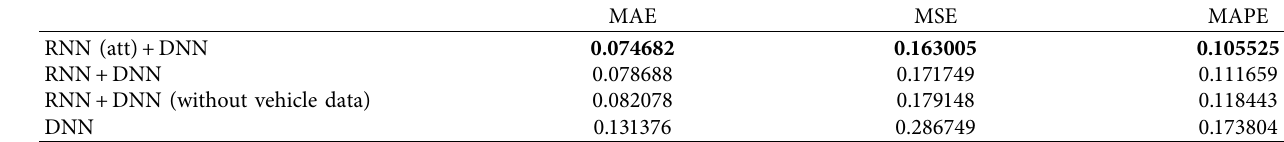
Table 1: Comparison of different models of travel energy consumption prediction.